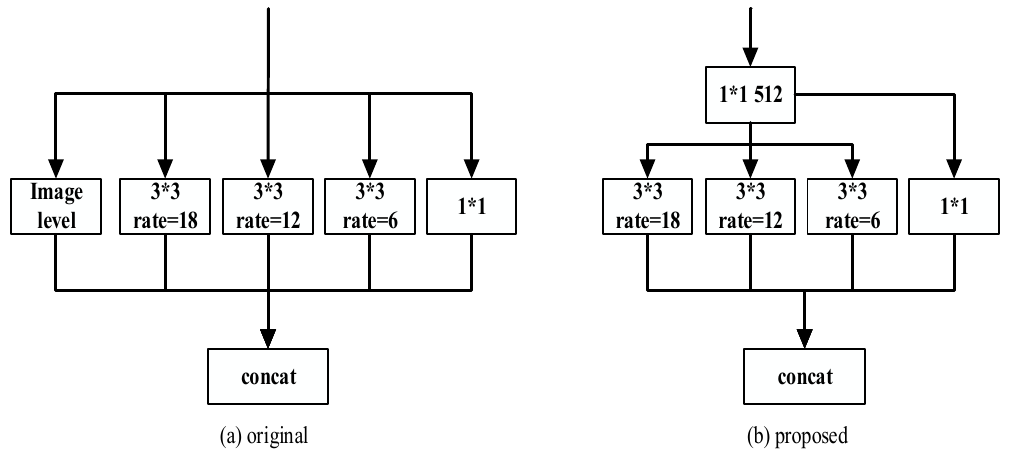
Figure 4. ( a ) The original ASPP structure. ( b ) The improved ASPP structure. We changed the input feature dimension of the atrous convolution and removed the image-level features.